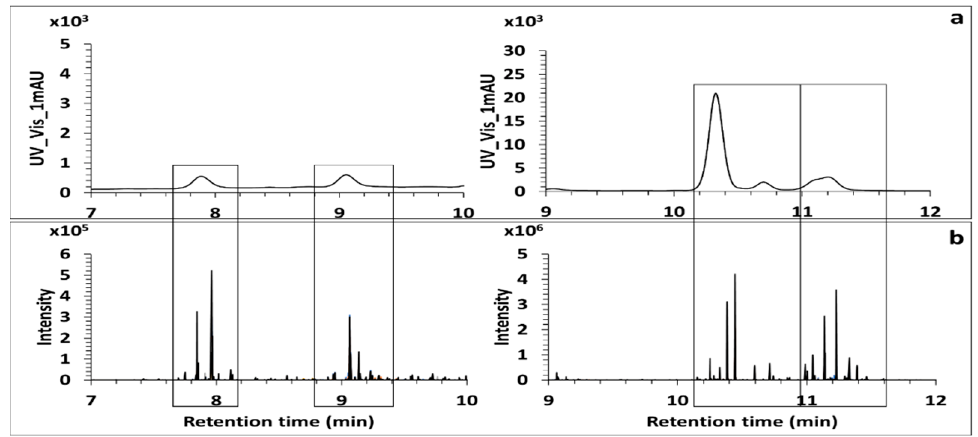
Figure 7. Screening of MAAs in the model alga Gymnogongrus devoniensis . UV Trace of MAAs recorded at (300–360) nm ( a ). XIC Trace MS² of the set of eight fragment ions by ddMS²/MS 3 untargeted analysis ( b ). All the peaks observed in the XIC trace MS² indicate all the retention times for which MAAs were detected in the extract. Table 7. Semi-quantitative analysis of MAAs detected in Gymnogongrus devoniensis . Amounts of MAA was estimated with an error of 10% regarding the signal intensities observed between the purified MAAs porphyra-334, shinorine and palythine injected at the same